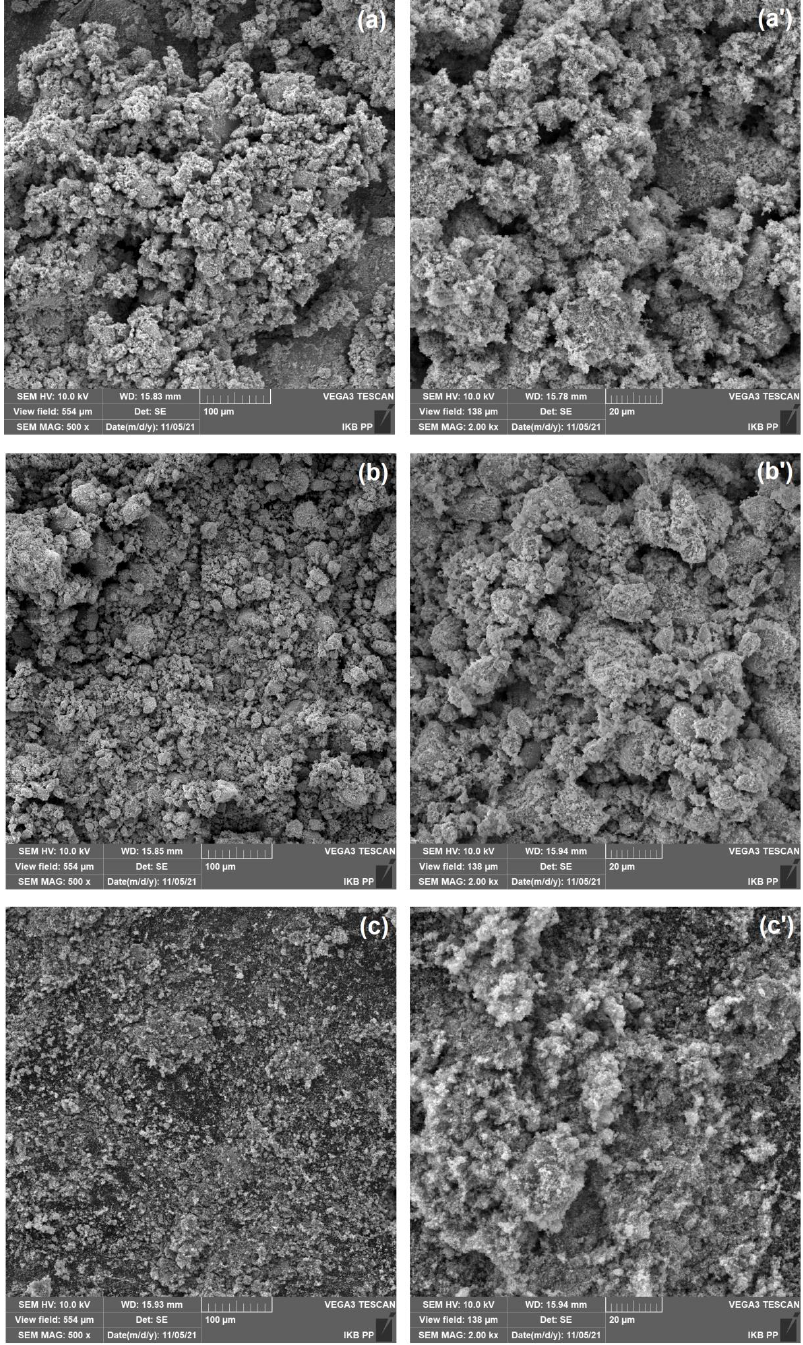
Figure 3. SEM images of ZnO ( a , a’ ), CuO ( b , b’ ) and TiO 2 ( c , c’ ) at two different magnifications.